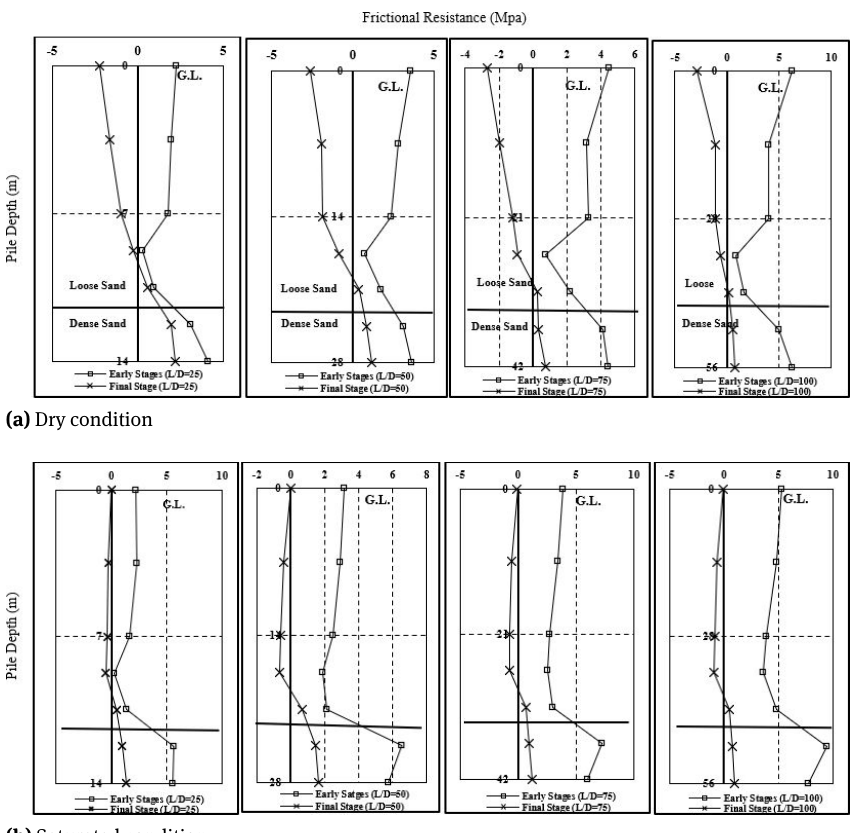
Figure 7: Frictional resistance of the pile shaft